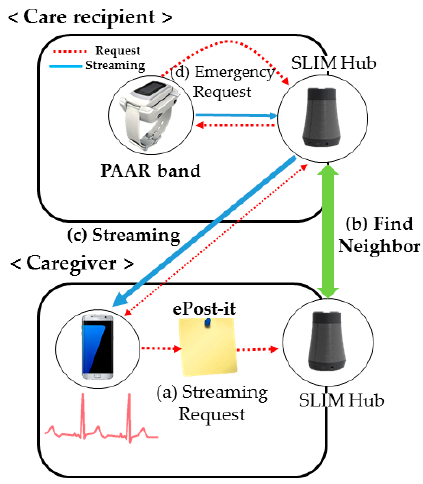
Figure 7. Sequence of streaming service operation.